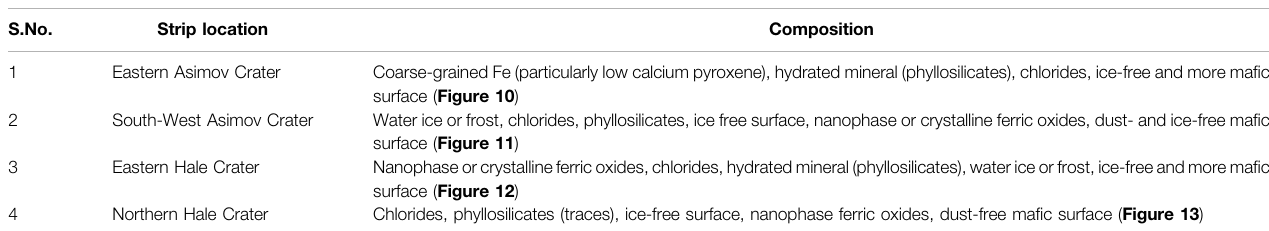
TABLE 2 | Asimov and Hale Craters interpretation made on the basis of summary products derived using CRISM data as RGB color composite/browse product.